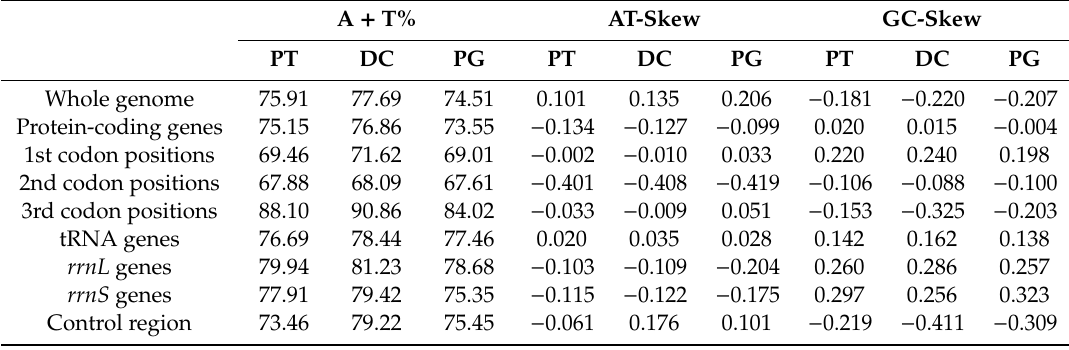
Table 1. Nucleotide composition of Pyrrhocoris tibialis (PT), Dysdercuscingulatus (DC), and Physopelta gutta (PG).